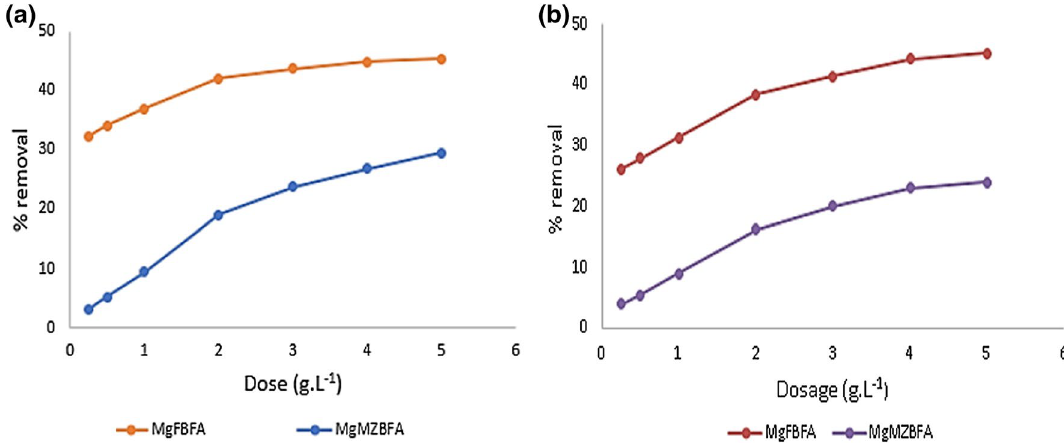
Fig. 12 Effect of adsorbents dose on the sorption of a PNAN, b NB on MgFZBFA and